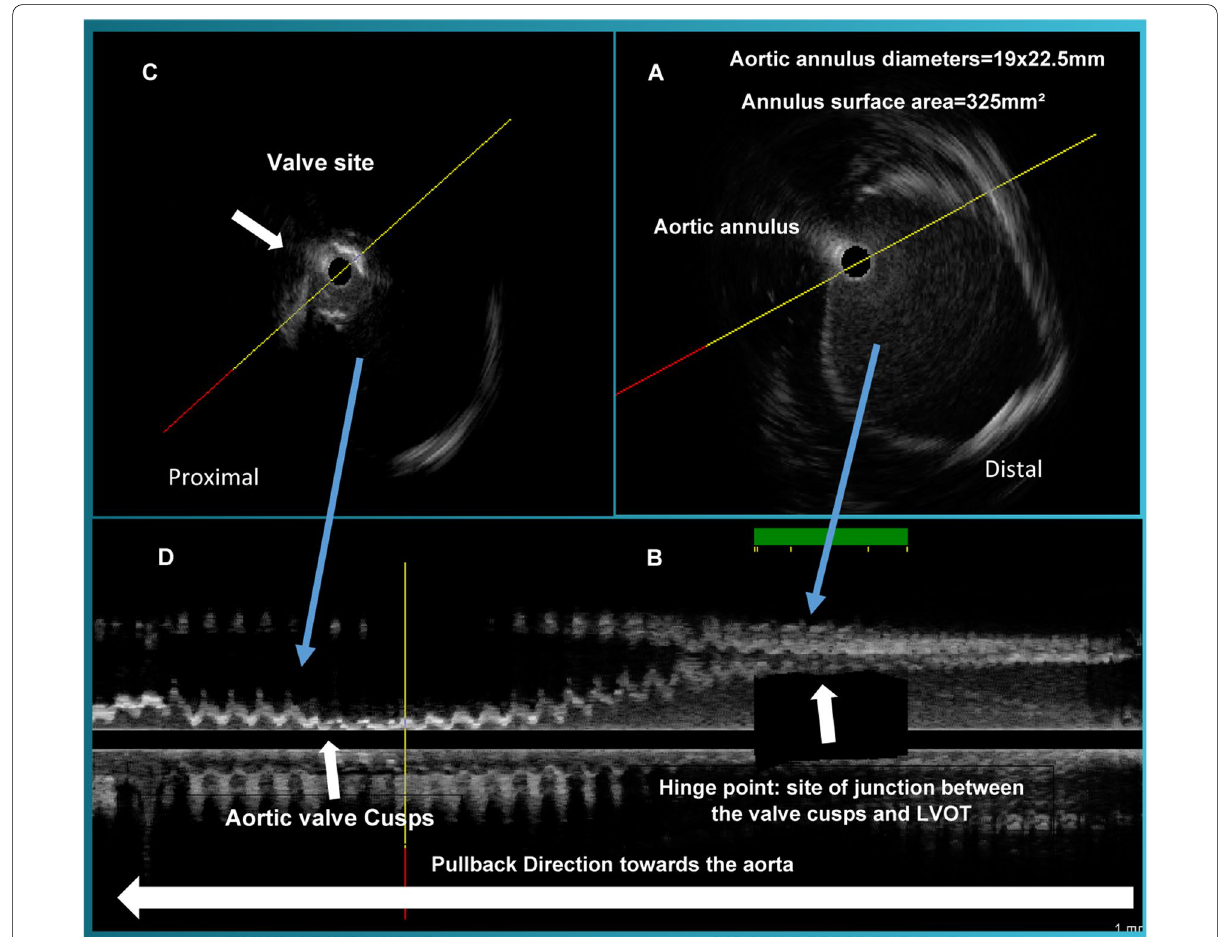
Fig. 1 Intravascular ultrasound measurements of the aortic annulus diameters and surface area. The pullback is shown from right to left. A The IVUS image of the aortic annulus, the annulus area was 325 mm 2 ; B corresponding longitudinal IVUS image at the site of junction between LVOT and the aortic cusps; C calcified aortic valve with signal drop-out; D corresponding longitudinal IVUS image of aortic valve